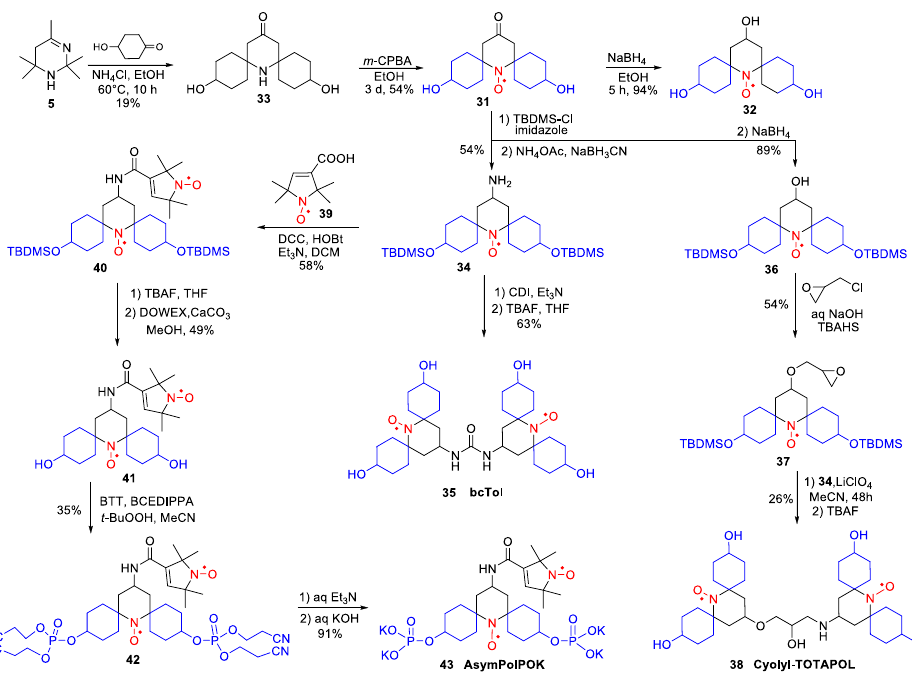
Scheme 7. Preparation of spin probes and dynamic nuclear polarization (DNP) agents on the basis of 4-hydroxycyclohexanone.